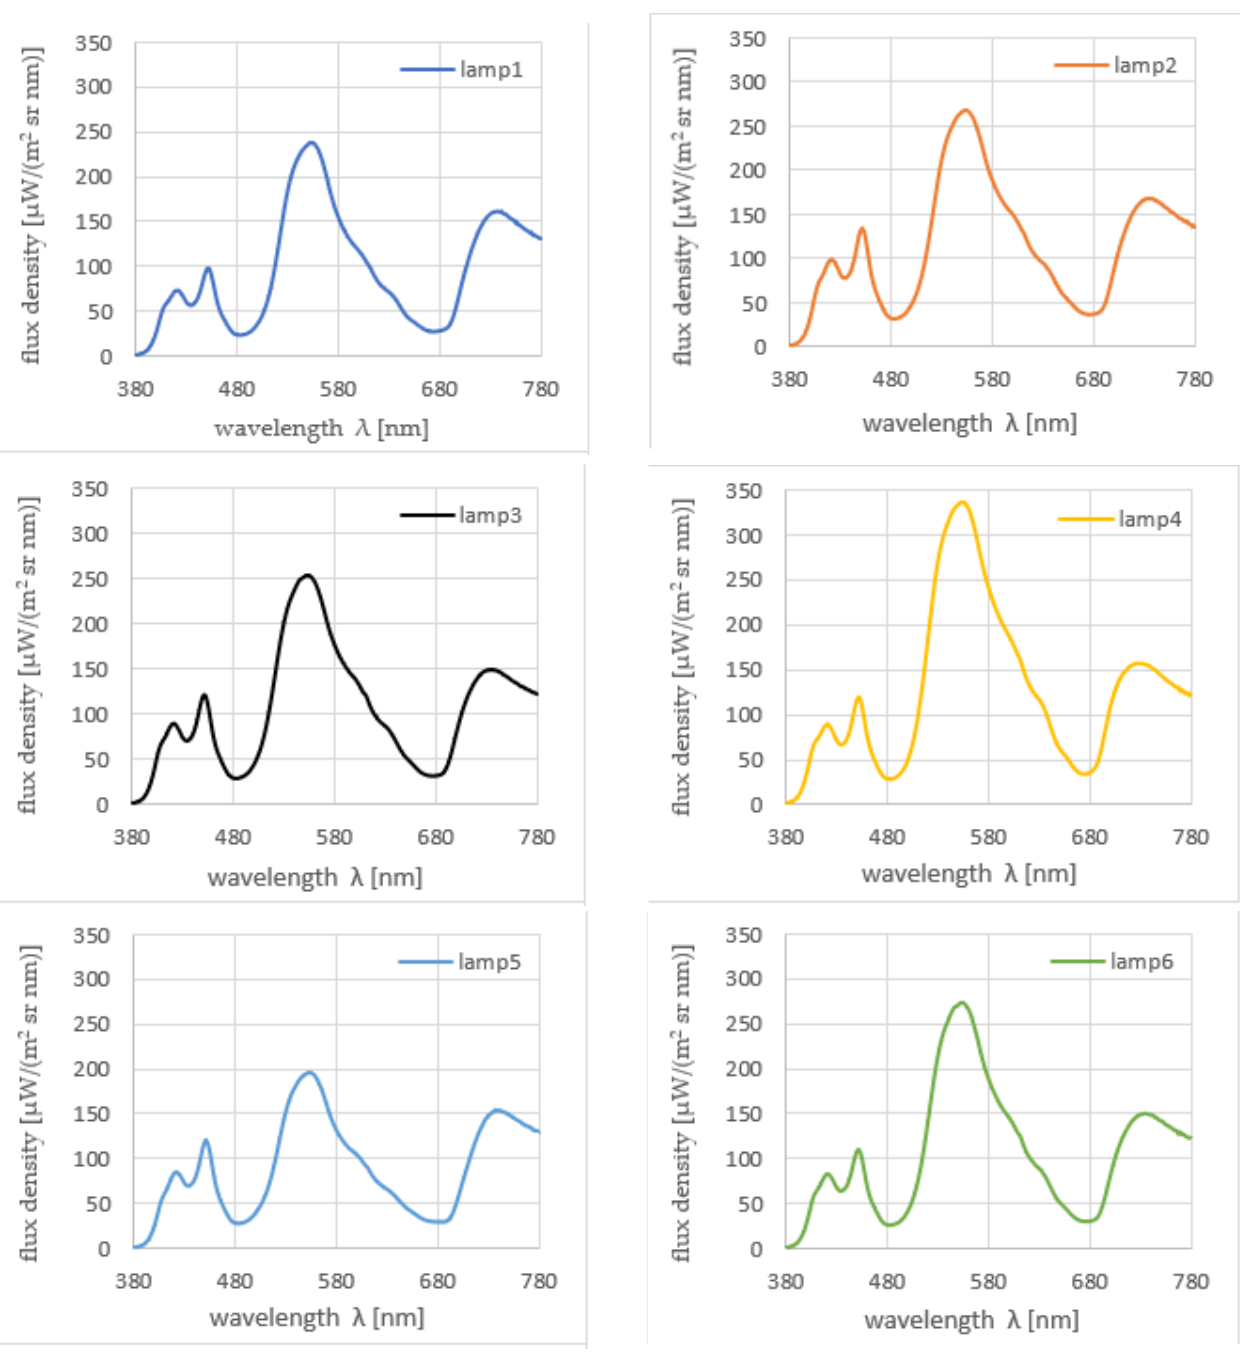
Figure 3. Averaged spectral characteristics of mint leaves grown under the light of all tested lamps. of which is bi-chromatic, i.e., contains only red and blue colors. In turn, the cluster corresponding to lamp 1 (the spectrum with the highest green content) is shifted up (towards the green region in the CIE color space), while the cluster corresponding to lamp 4 (containing far-red LEDs) is shifted to the right and up (towards the yellow region in the CIE color space). For the remaining lamps (lamp 2, lamp 3 and lamp 6) the color of the leaves is similar and corresponding clusters are located near the center of the group of all data points shown in Figure